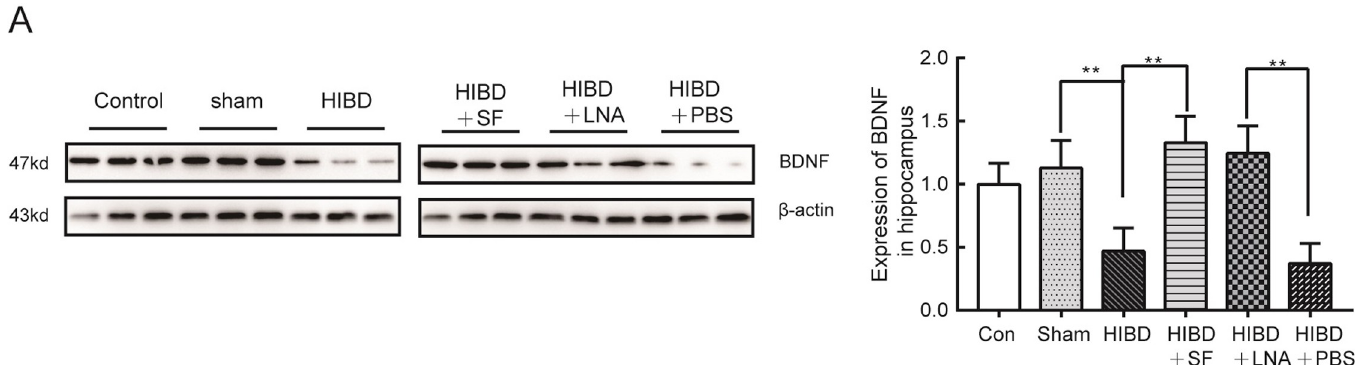
Fig 8. Western blot analysis of the protein expression of BDNF in the rat hippocampus. SF and LNA-miR-9 effectively increased the expression of BDNF in HIBD. (A) The expression of BDNF in rat hippocampus. �� P < 0.01 vs HIBD or HIBD+PBS. N = 6 for animal analysis.